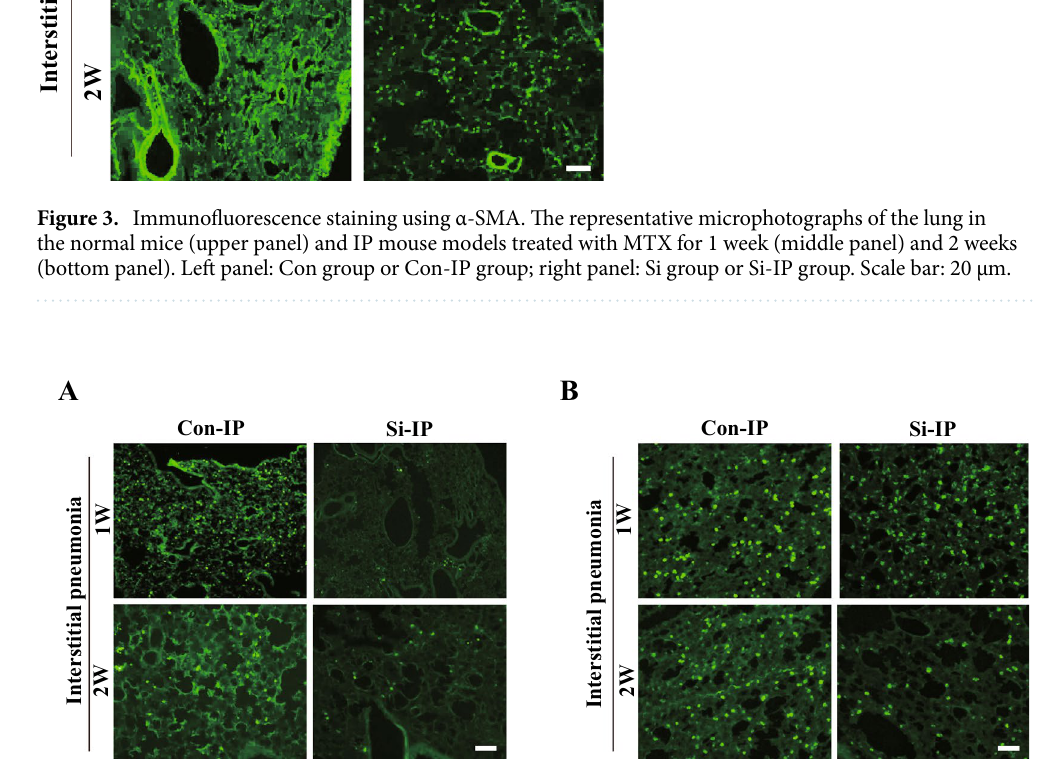
Figure 4. Immunofluorescence staining for Gr-1 ( A ) and F4/80 ( B ). The representative microphotographs of the lung in the IP mouse models treated with MTX for 1 week (upper panel) and 2 weeks (bottom panel). Left panel: Con-IP group; right panel: Si-IP group. Scale bar 20